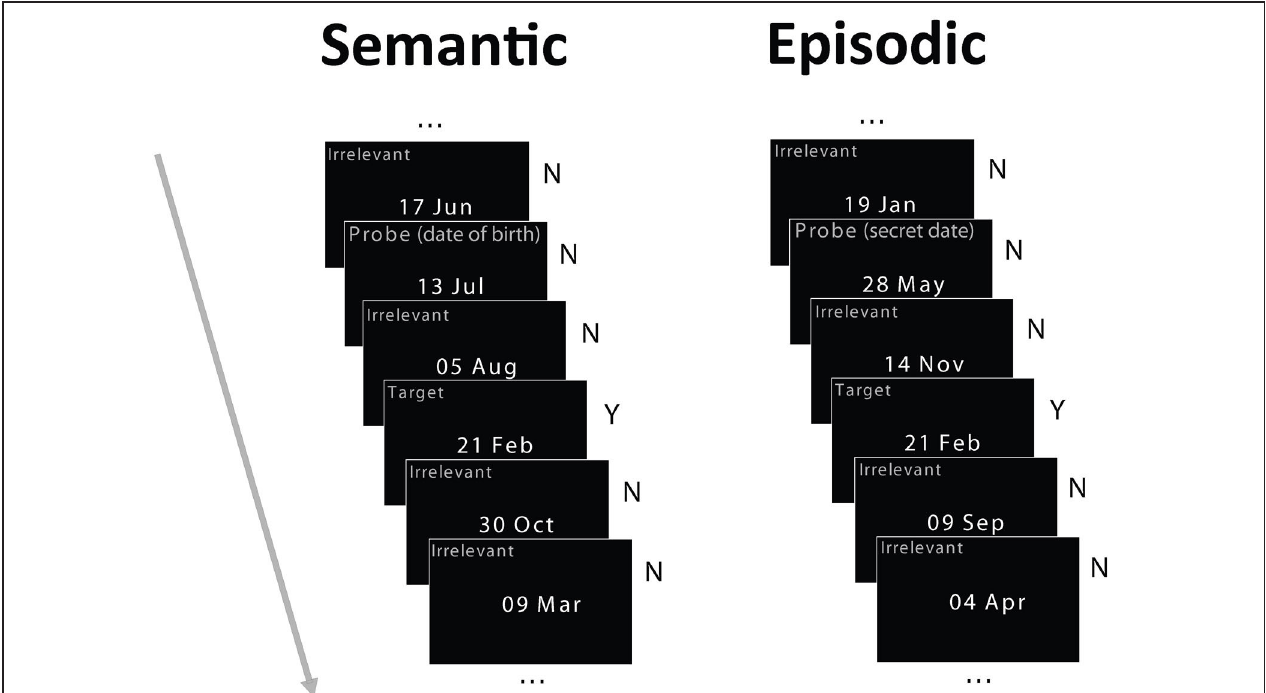
an envelope each participant opened just before the study. Participants reported whether they possessed associated memories for any of the dates, responding honestly to both the irrelevant dates (by pressing the “no” key) and the target date (by pressing the “yes” key), but lying about their birth date or secret date (by pressing the “no” key). Note: Item type labels in the figure shown for illustration only and did not appear on the